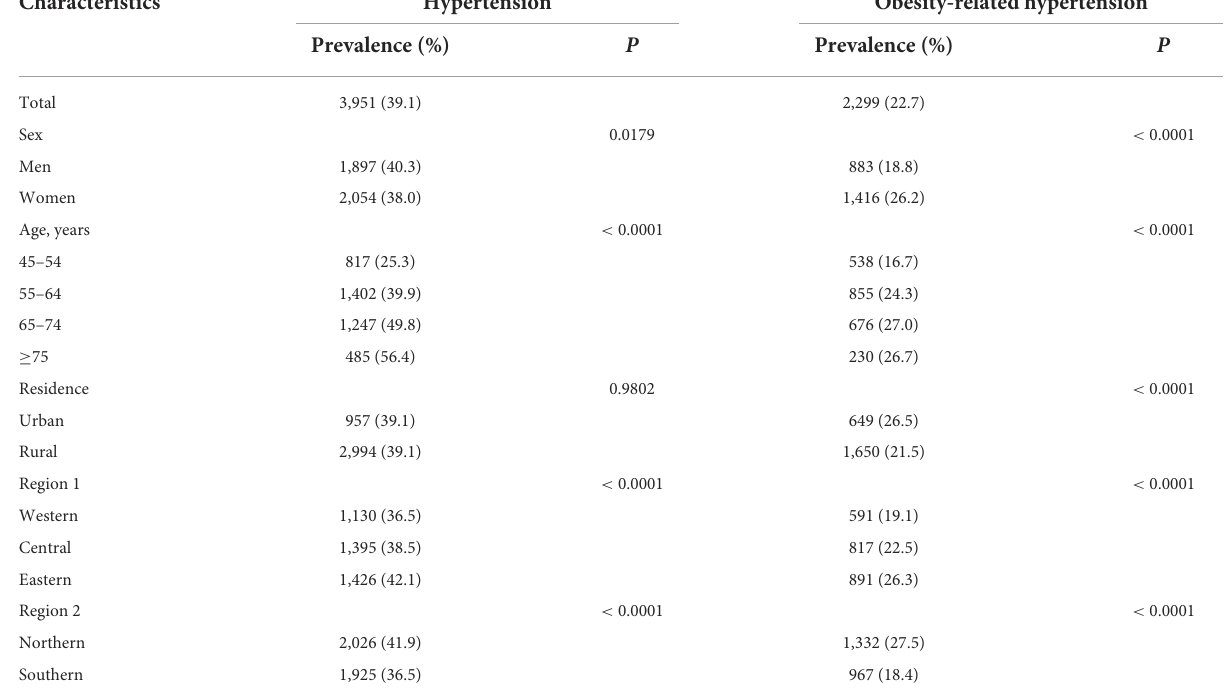
TABLE 3 The prevalence of hypertension and obesity-related of hypertension among different sex, age, residence, region.